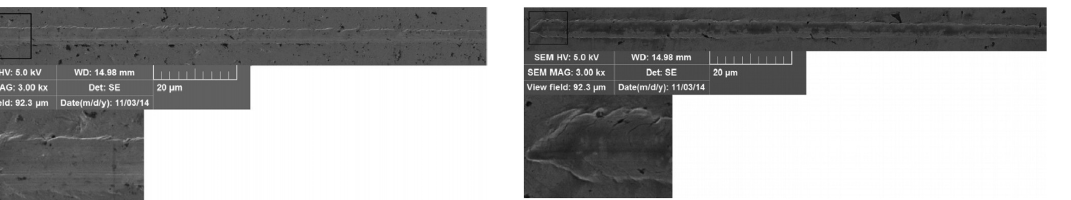
Figure 9. SEM of the 50 mN scratch on the 20 V (1 h) H (1 mol.L -1 ). Image obtained with a magnification of PO 3 4